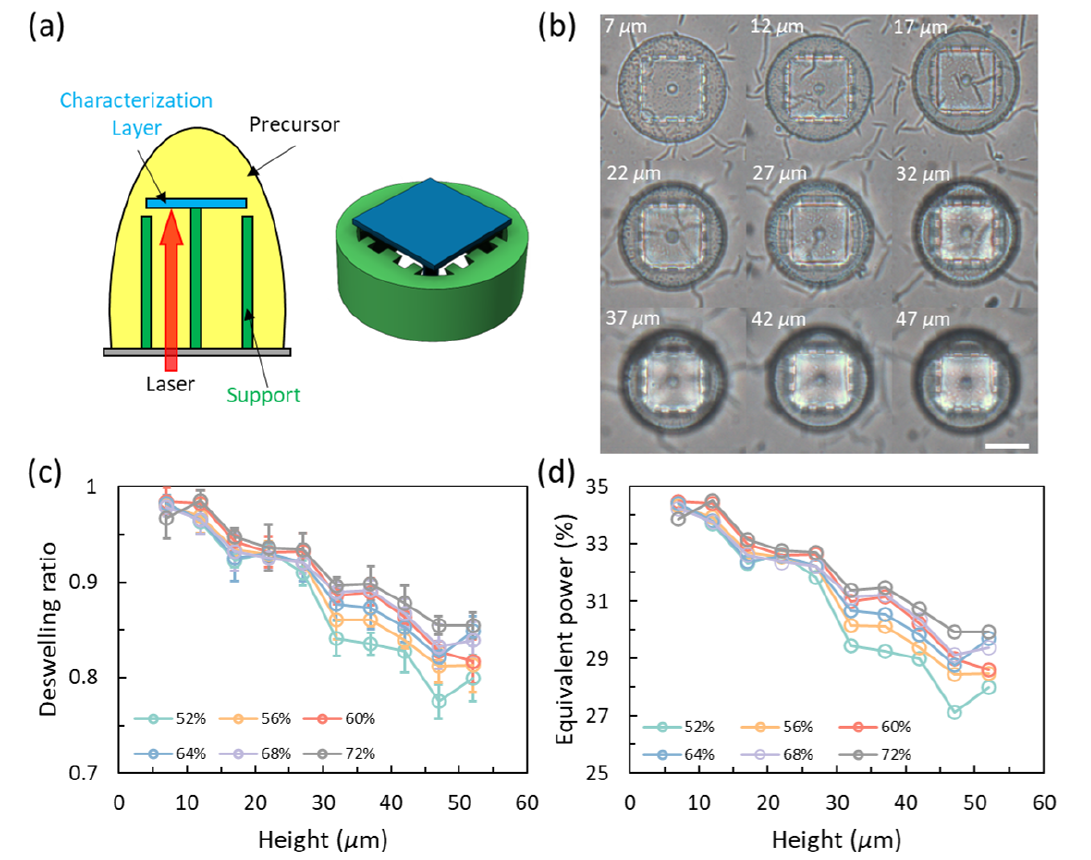
Figure 3. Power decay for penetrating the hydrogel precursor. ( a ) Schematic and model used for precursor penetration. ( b ) Deswelling of samples for penetration different depths with an initial power of 56%. Scale bar: 20 µ m. ( c ) Deswelling ratios at different penetration depths with different initial laser powers. ( d ) The equivalent power converted from ( c ) based on the standard prints.